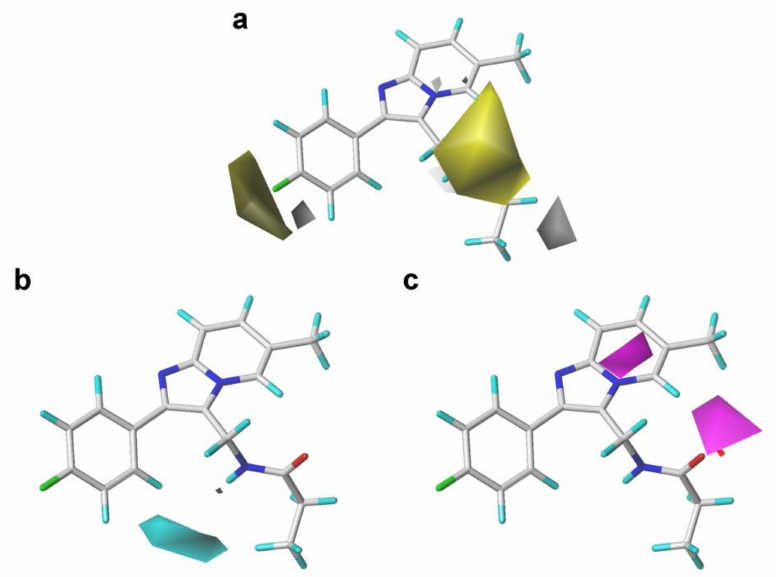
Figure 5. Contour maps of the optimal CoMSIA model with compound 14 as a template. ( a ) The hydrophobic field. ( b ) The hydrogen bond donor field. ( c ) The hydrogen bond acceptor field.